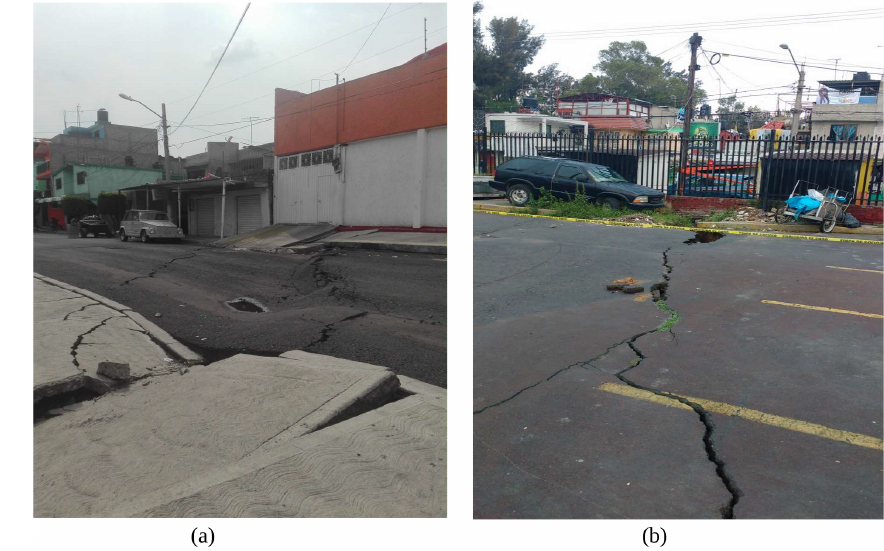
Figure 1. (a) Camarón Street fracture, Tláhuac, Mexico City. (b) Fracture in Albarradas, Iztapalapa, Mexico